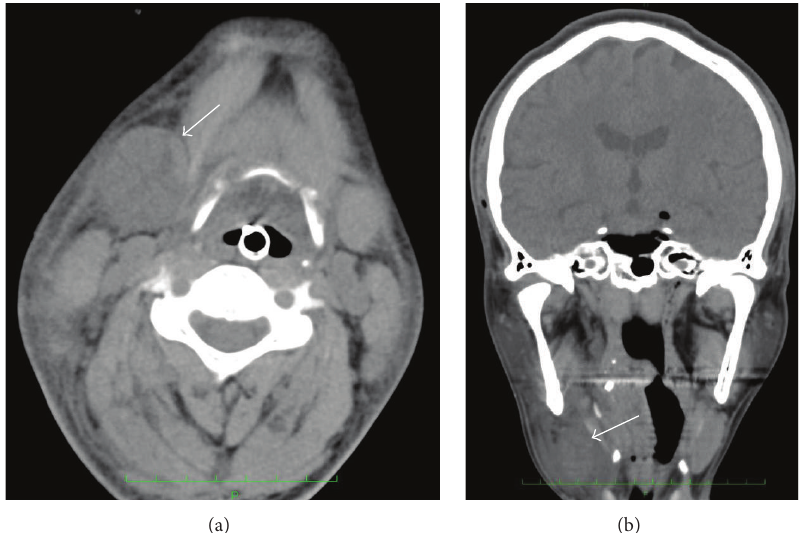
Figure 2: Axial (a) and coronal (b) images of computed tomography 1 hour after operation showing swelling of the right submandibular gland and the associated edematous tissue (arrow).